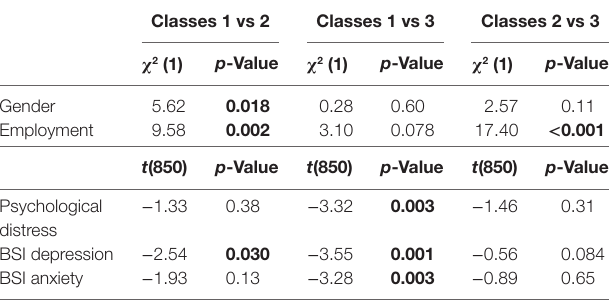
TaBle 7 | Pairwise comparisons of socio-demographic factors and mental health outcomes across classes. classes 1 vs 2